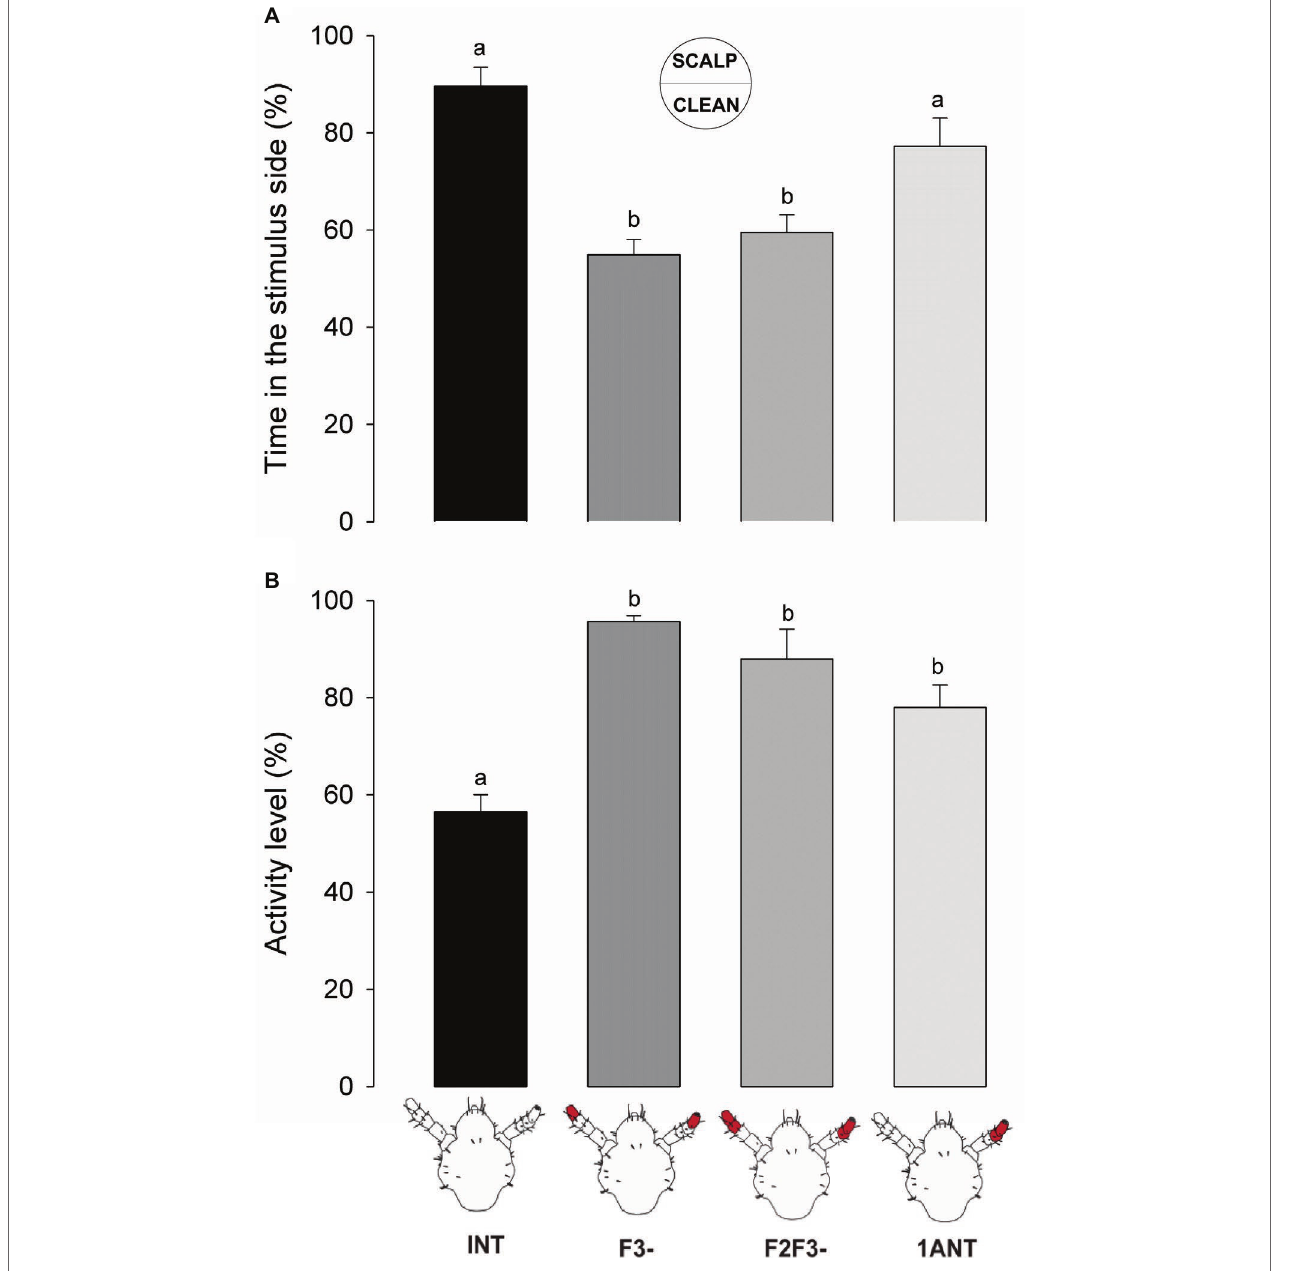
FIGURE 3 | Behavioral responses of intact and antennectomized head lice to scalp chemicals. (A) Preference of intact and antennectomized lice in a two-choice arena, measured as the percentage of time spent at the scalp chemical side. Intact insects ( INT) and those with only one antenna ablated ( 1ANT) spent significantly more time at the scalp chemicals side of the arena than those with F3 ( F3- ) or F2 and F3 ( F2F3- ) ablated. (B) Activity levels of intact and antennectomized head lice, measured as the percentage of the experimental time they remained active over the arena. INT lice were significantly less active than all antennectomized ones ( F3- , F2F3- , and 1ANT ). Each column represents the mean of 15 insects. Different letters indicate significant differences (one-way ANOVA, p <